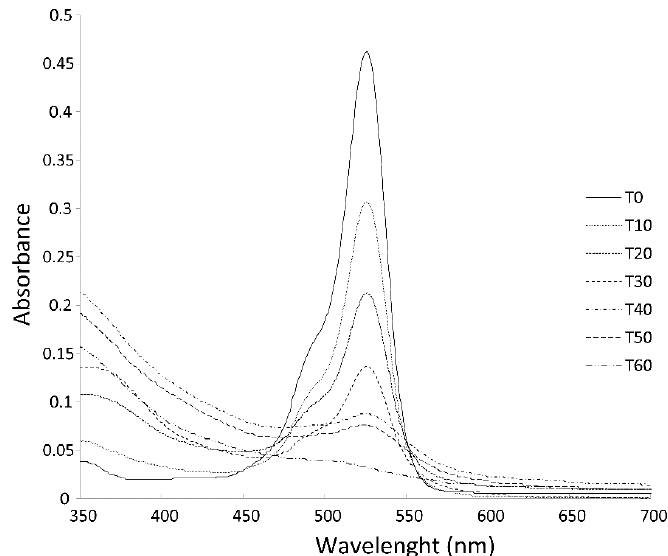
Figure 7. Effect of the type of treatment analyzed by UV/Vis. EO – PAP sequenced treatment (30 min of EO + 30 min of PAP) after 60 min of treatment of azo dye Carmoisine (5 ppm). The pH of the sample was adjusted to 5.2. The treated volume was 1.0 L. Table 1. Electronic transitions species oxidative generates during the PAP process.